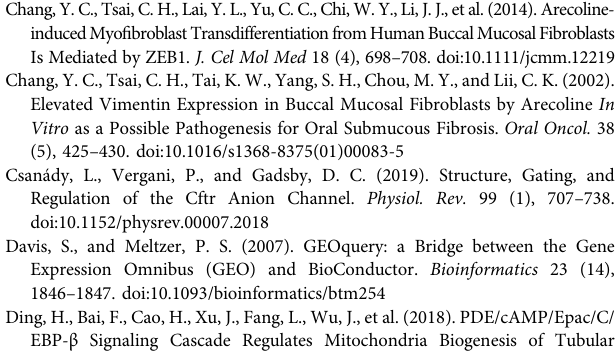
Supplementary Figure S1 | Expression of PDE4A in head and neck cancer based on TCGA database and clinical samples. (A) the expression of PDE7A, PDE6D and